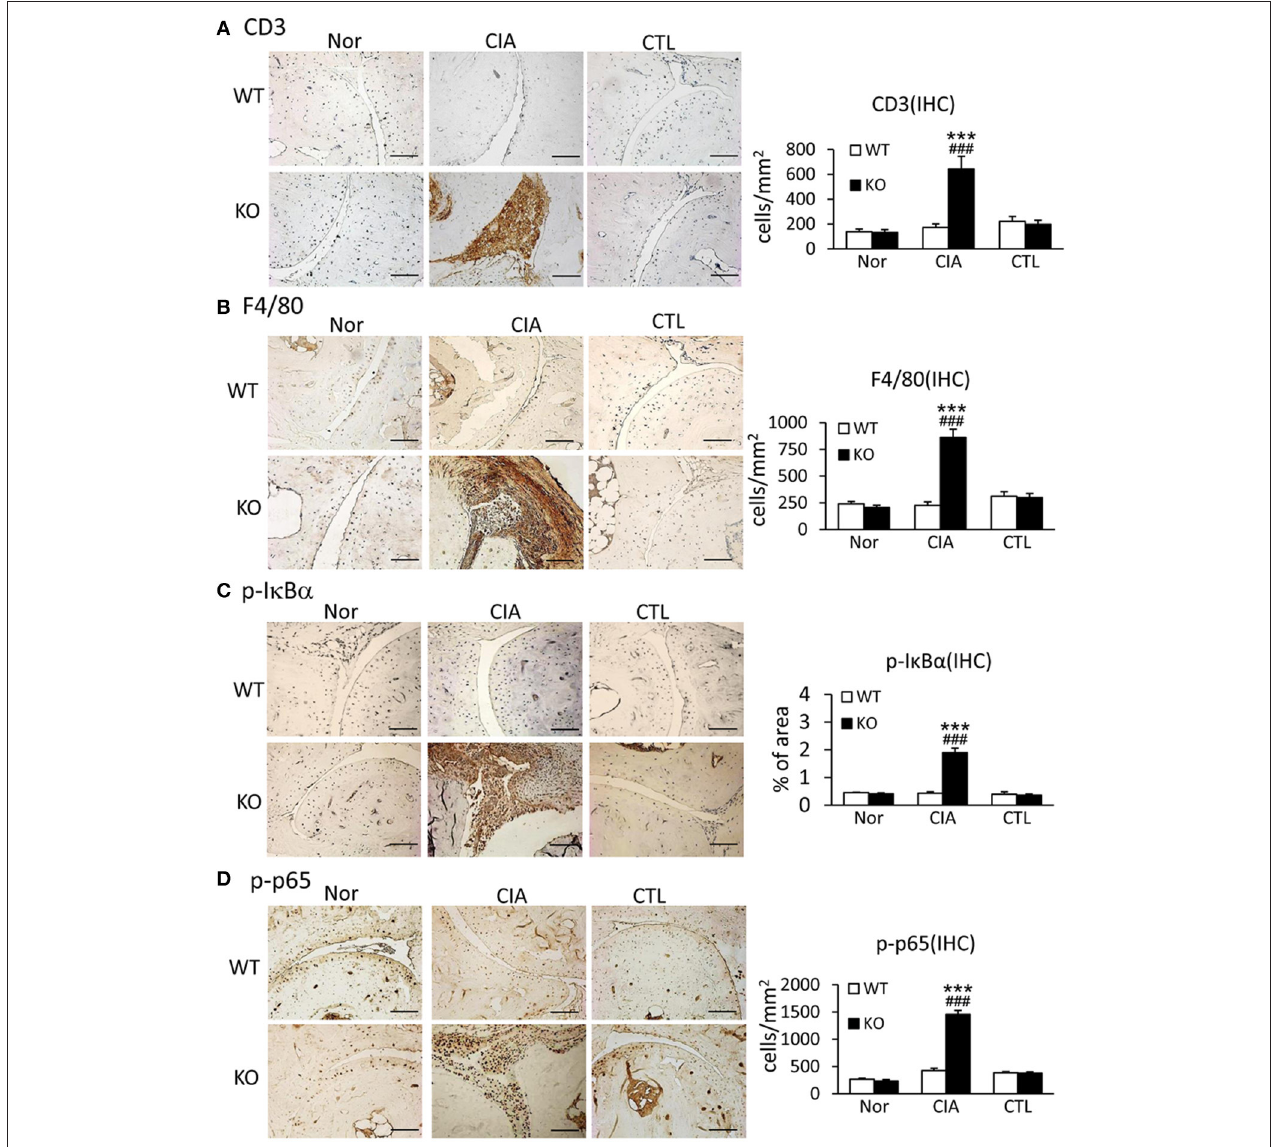
FIGURE 4 | Deletion of Smad7 largely enhances synovial inflammation and activation of NF- κ B signaling in CIA mice. (A) CD3 expression. (B ) F4/80 expression. (C) Phospho-I κ B α . ( D) Phospho-p65. Results show that severe joint inflammation evidenced by many CD3 + T cells and F4/80 + macrophages and a marked activation of NF- κ B signaling developed in Smad7-KO but not in Smad7-WT CIA mice (CD-1 background). Data are expressed as mean ± S.E. for group of 8 mice. *** p < 0.001 vs. control (CTL); ### p < 0.001 vs. WT-CIA group. Scale bar, 50 µ